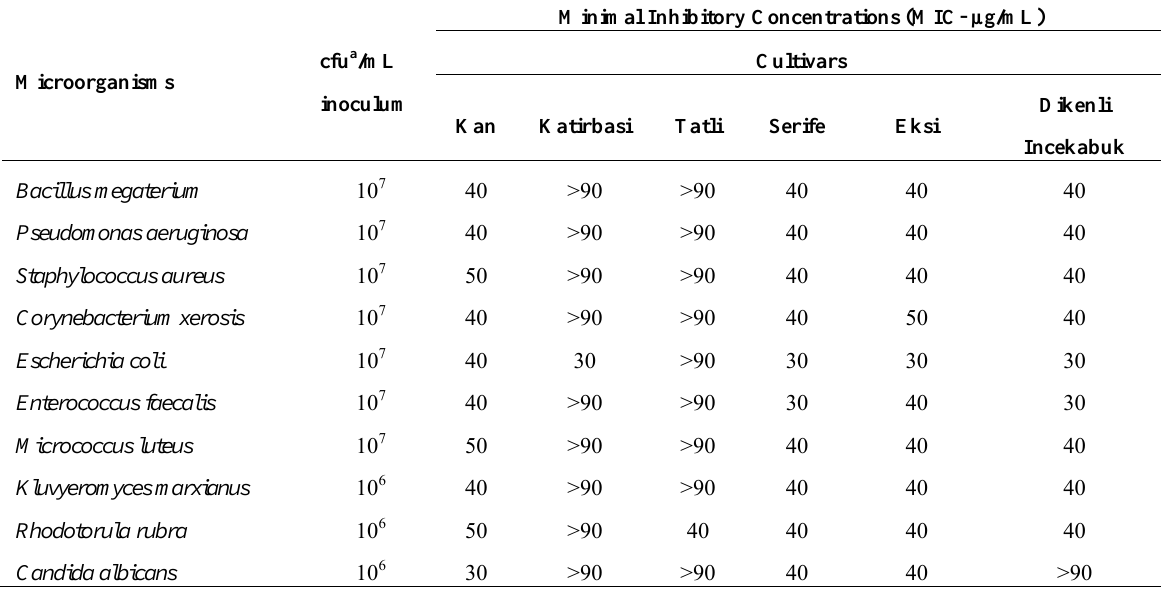
Table 3. Minimum inhibitory concentration of pomegranate cultivars on some microorganisms. Minimal Inhibitory Concentrations (MIC- µg/mL) cfu a /mL Microorganisms inoculum